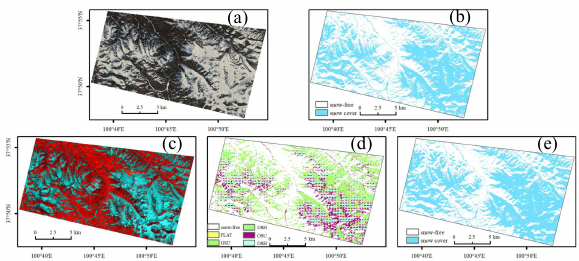
Figure 4 . Dynamic threshold extraction snow map on March 23, Sentinel-2 false color image; (d) dynamic threshold to